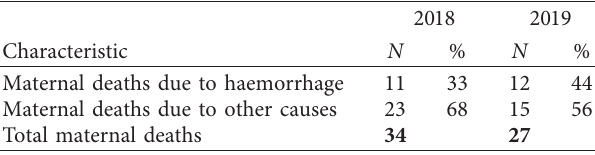
Table 1: All maternal deaths in 2018–2019 ( N �